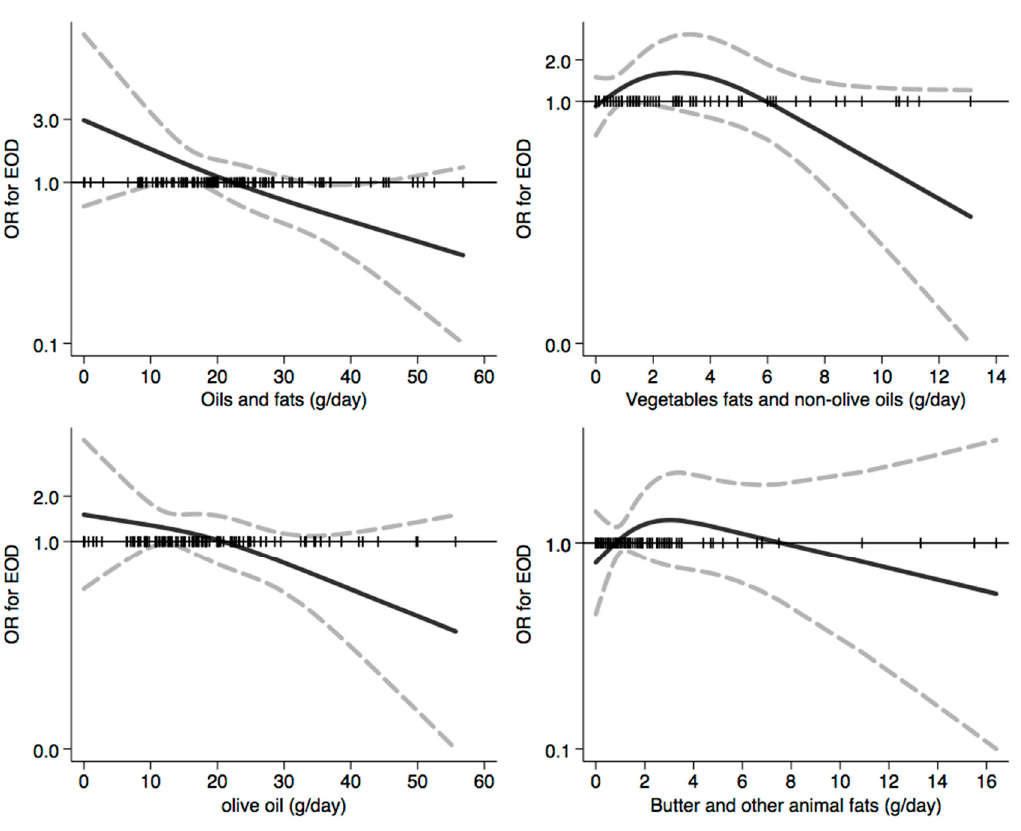
Figure 9. Spline regression analysis of early-onset dementia (EOD) risk for increasing intake of oils and fats. The black line indicates odds ratios for dementia risk; dash gray lines are 95% confidence limits; the reference line at 1.0 with black spikes indicates the distribution of participant intake.